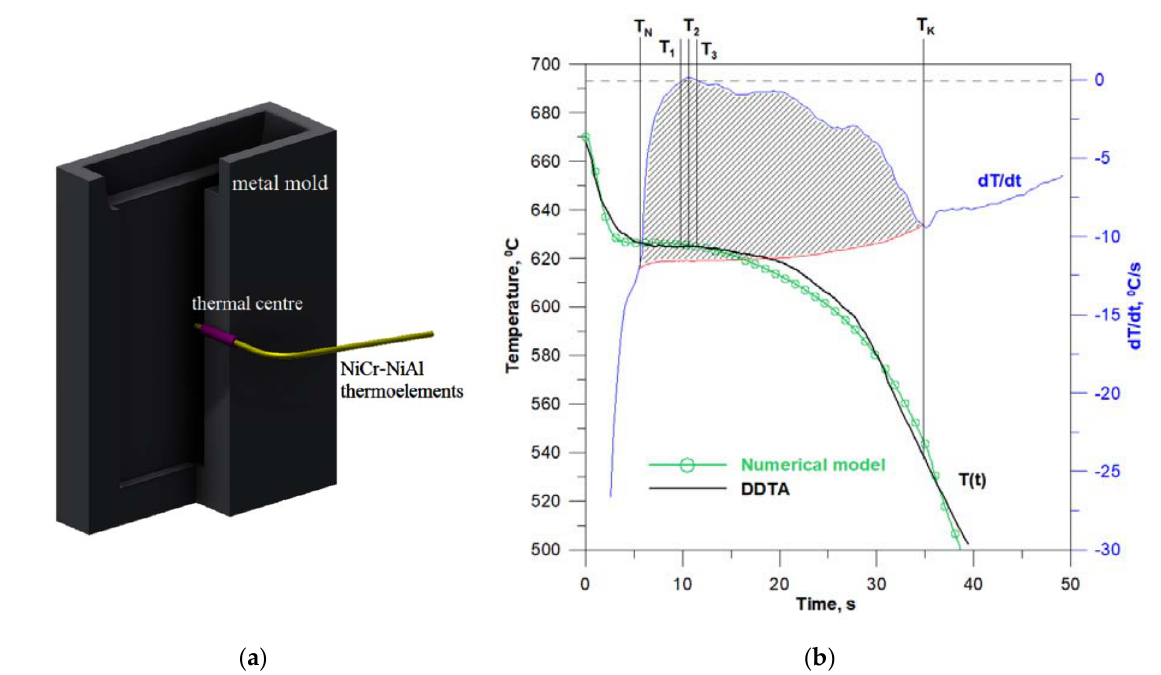
Figure 9. DDTA test results: ( a ) appearance of a metal mold with a thermocouple, ( b ) solidification and cooling curves of the Al + 5 wt.% Mg alloy.